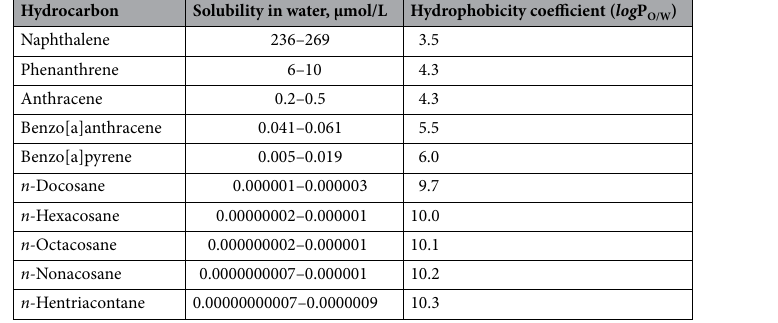
Table 1. Physicochemical properties of